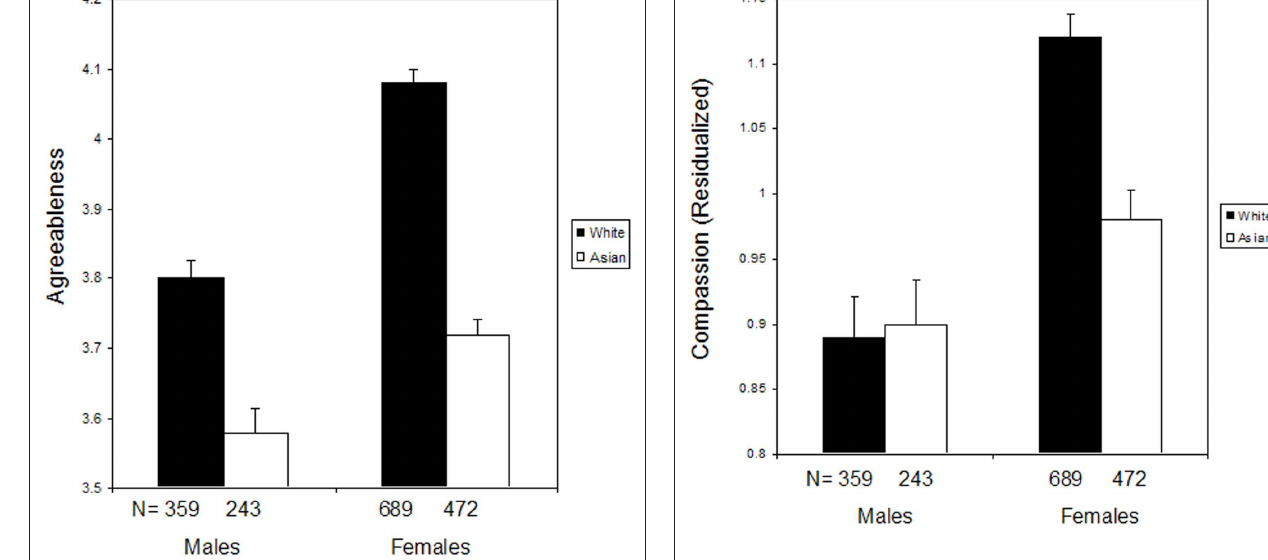
FIguRE 3 | Ethnicity moderates gender differences in Compassion (residualized). Residualized scores are depicted as the scores plus 1, for ease of interpretation.